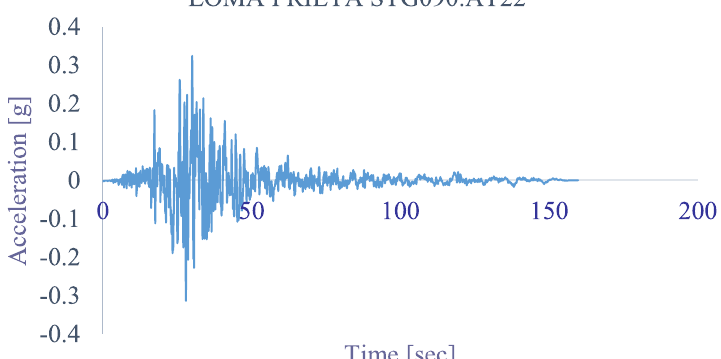
Fig. 7 The other record of the horizontal component (STG090) of the Loma Prieta earthquake